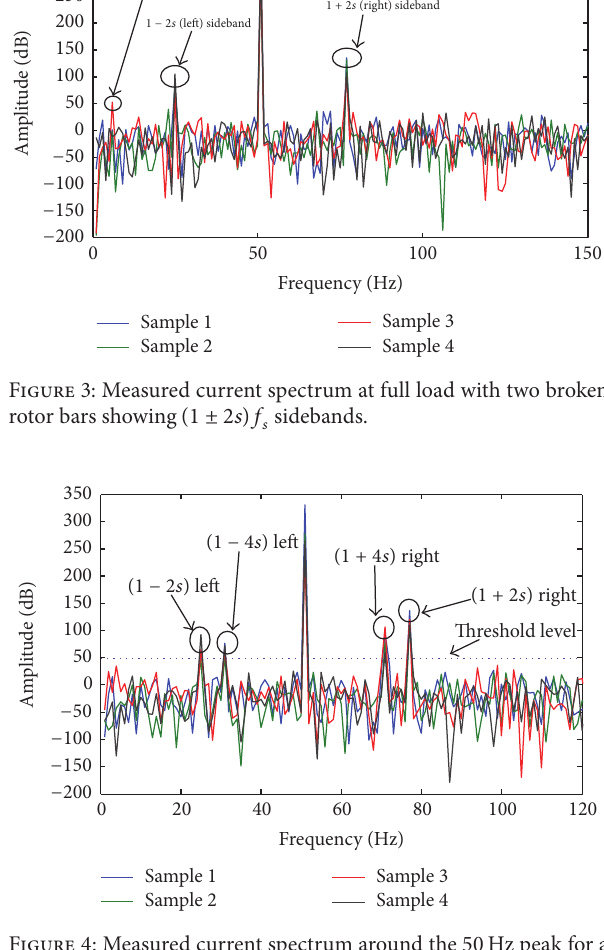
Figure 4: Measured current spectrum around the 50Hz peak for a motor with more broken rotor bar and crack showing (1±2𝑠)𝑓 𝑠 and (1 ± 4𝑠)𝑓 𝑠 sidebands in both